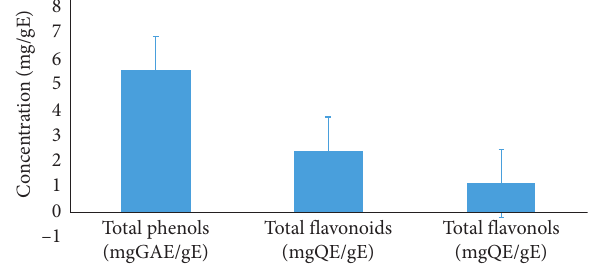
Figure 1: Quantitative analysis of phytochemical constituents of the leaves of D. edulis . GAE: gallic acid equivalent; QE: quercetin equivalent; E: extract.